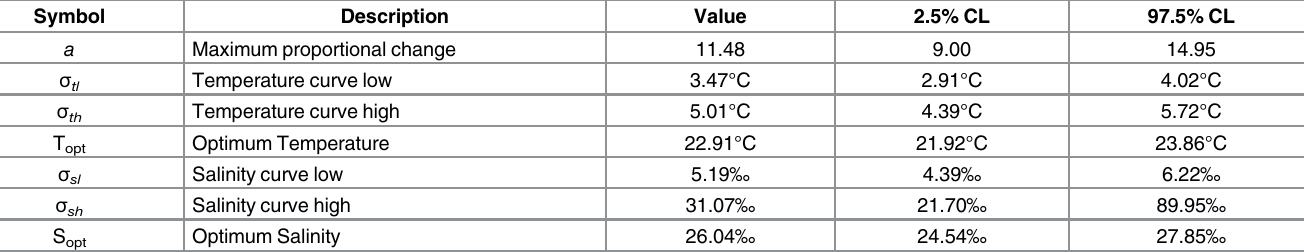
Model output describes proportional change in polyp density for different temperature and salinity values as described in Eqs 1, 2 and 3. Models were fi t to data collected from a matrix of eight temperature and ten salinity treatments, each replicated six times. Estimated parameter values are based on the best fi t parameters and 95% maximum likelihood pro fi le con fi dence limits are